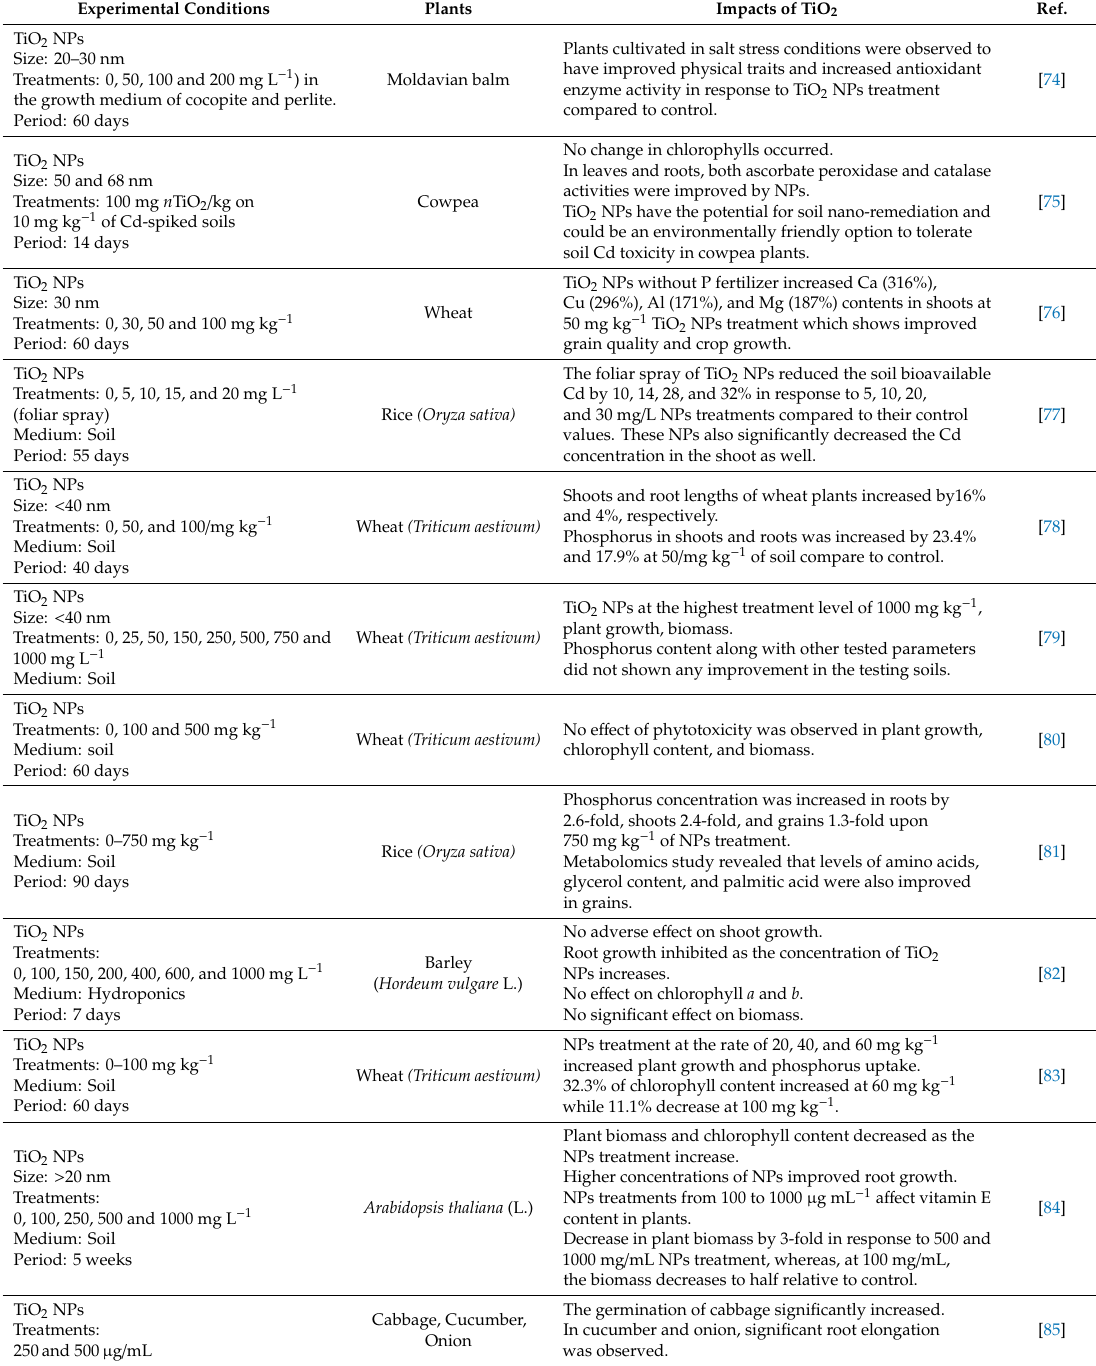
Table 4. TiO 2 NPs applications since 2010 on di ff erent plants and their impacts. Experimental Conditions Plants Impacts of TiO 2 Ref. Plants cultivated in salt stress conditions were observed to have improved physical traits and increased antioxidant Moldavian balm enzyme activity in response to TiO 2 NPs treatment compared to control.